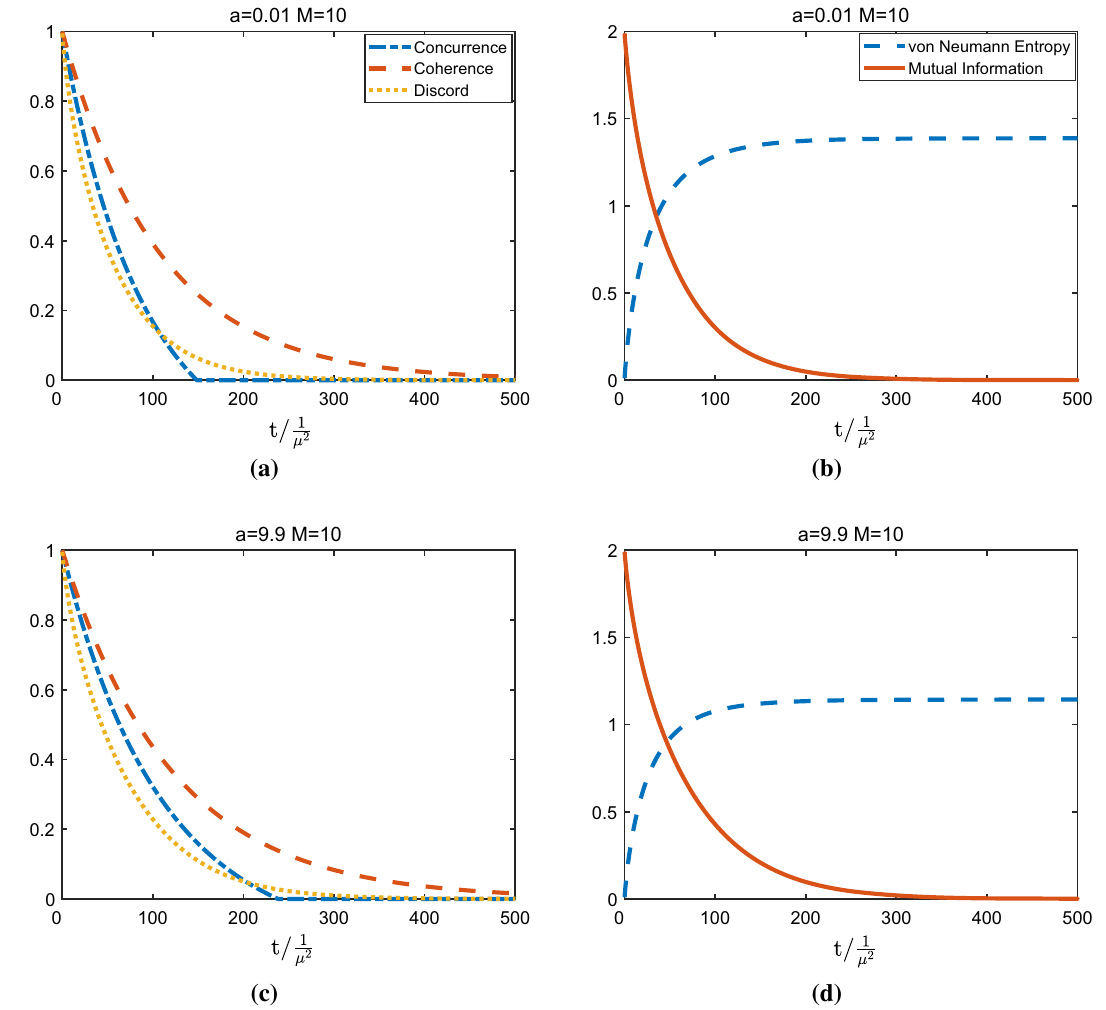
Fig. 5 Nonequilibrium quantum correlation evolution vs. time with the different angular momentum per mass in the unit of 1 μ M = 10 (upper panel) and a = 9 . 9, M = 10 (lower panel). Other parameters are the same as those in Fig.